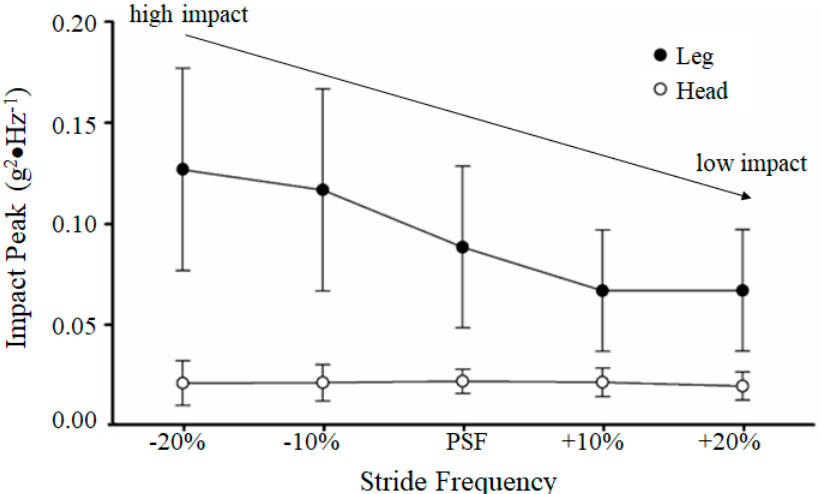
Figure 2. Mean ( ± SD) of impact peak of tibia and resulting peak of the head during the foot–ground collisions at the preferred stride frequency (PSF) and plus and minus percentages of the PSF (adapted from data in Hamill et al. [20]) .